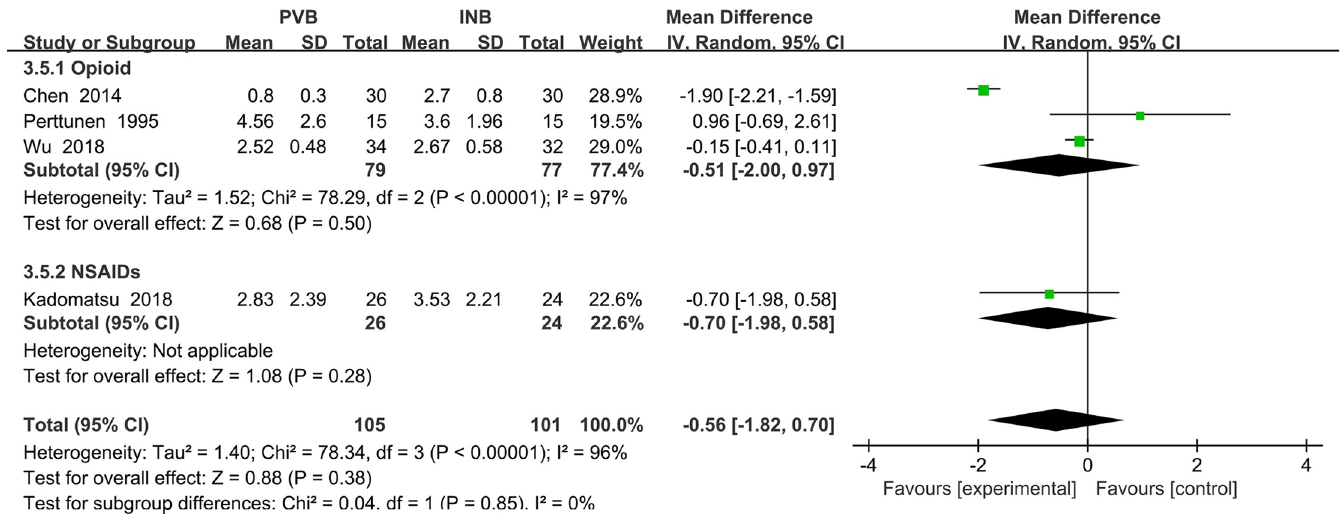
Fig 8. Subgroup analysis of comparison: Opioids drug VS NSAIDs. Outcome: VAS at rest at the first 2 h.